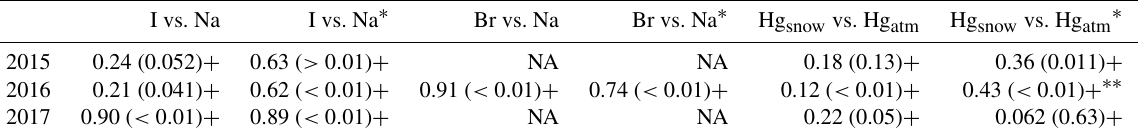
Table 2. Correlation coefficient between iodine and sodium, bromine and sodium (only 2016), and atmospheric and snow mercury. The correlation is calculated for the entire dataset. When the correlation is marked with an asterisk, this indicates that the correlation has been calculated without considering the snowfall events. During the 2016 experiment the correlation between Hg snow and Hg atm ∗ has been de- trended to highlight the antiphase between Hg atm and Hg snow . The “ + ” and “ − ” indicate whether the association is positive or negative, and the values in parentheses are the p values. NA = not